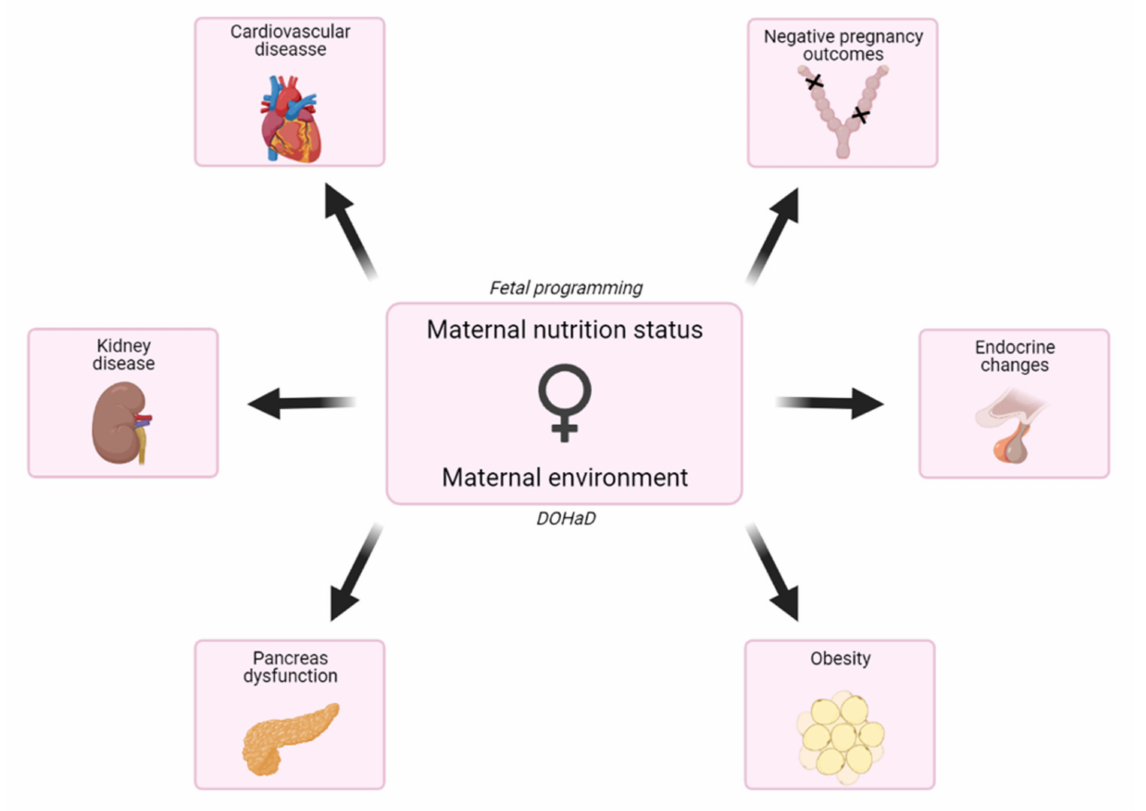
Figure 1. Effects of maternal nutrition status and environment exposition on the progeny. The fetal programming hypothesis postulates that changes occurring during fetal growth, such as a lack of nutrients, can predispose them to disease in adulthood. The fetal programming hypothesis is completed with the Developmental Origins of Health and Disease (DOHaD) concept, which includes exposition to toxins and chemicals, use of drugs, infections and other stimulations but also nutritional status during pregnancy, and early